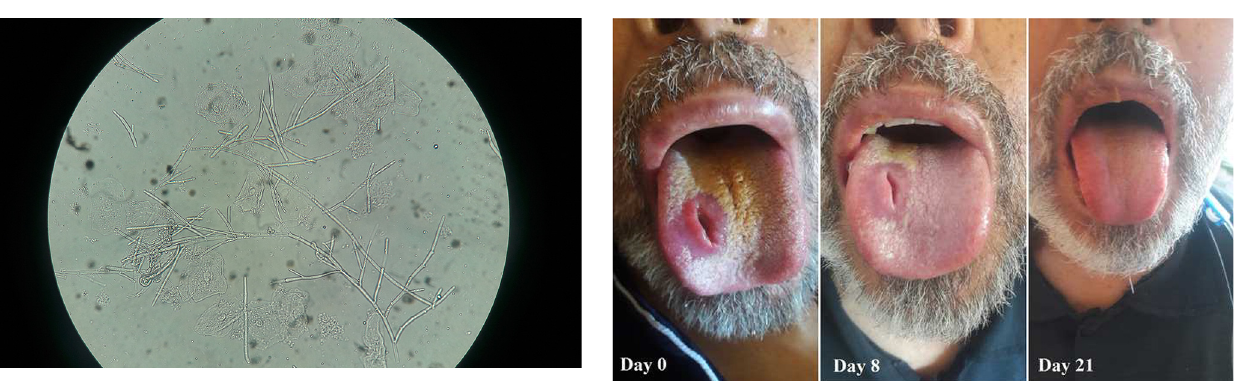
Fig. 4. Clinical course of tongue lesions after initiation of